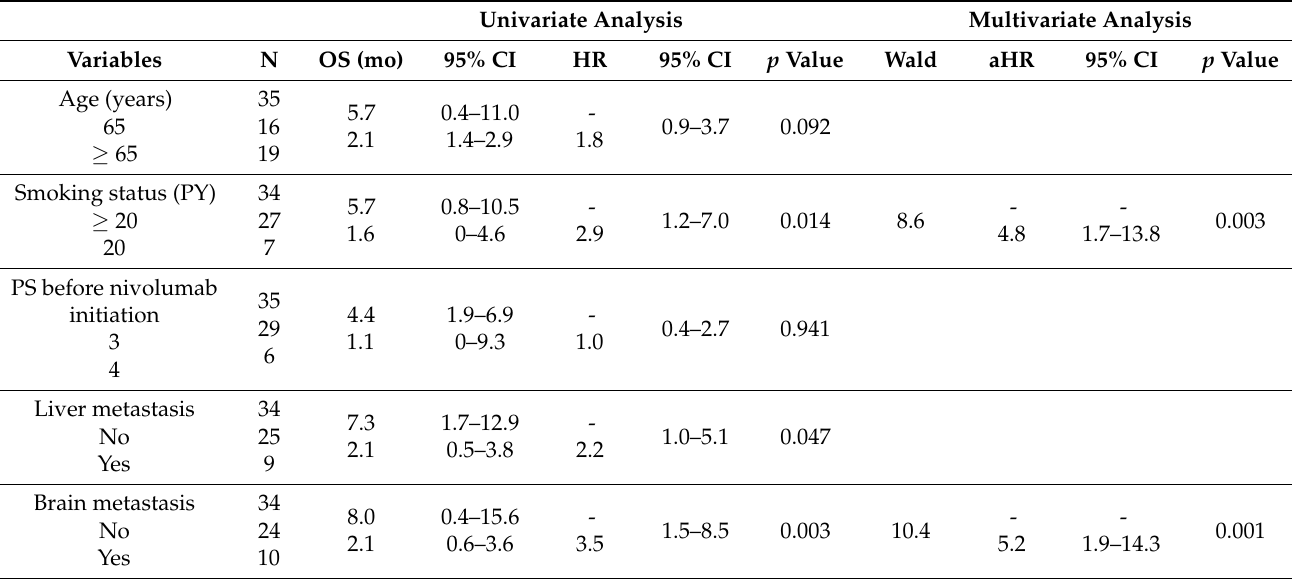
Table 2. Univariate (Kaplan–Meier) and Multivariate Analysis (Cox proportional hazards) results. Univariate Analysis Multivariate Analysis